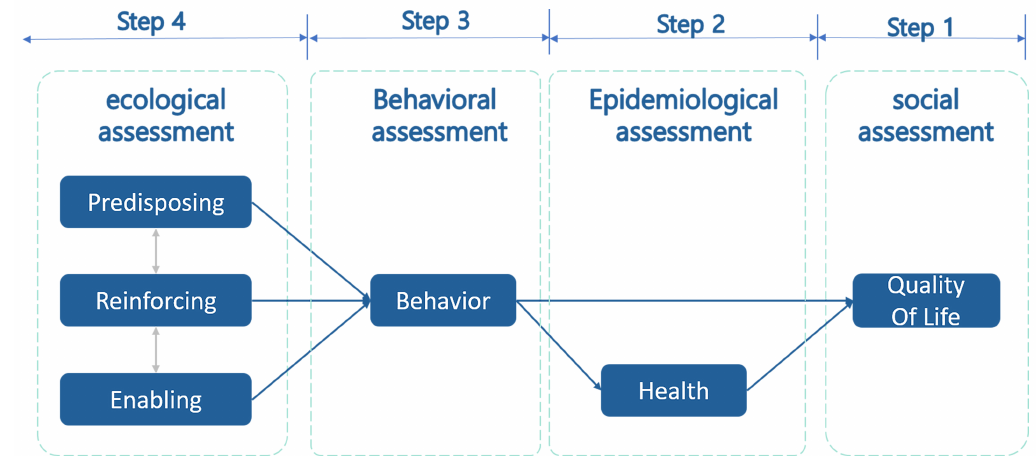
Fig. 1. Statistical schematic of structural